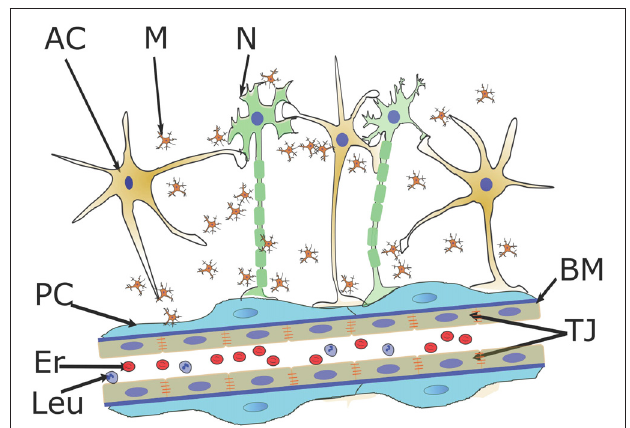
FIGURE 1 | Blood-brain barrier (BBB) structure and intercellular communications within the neurovascular unit (NVU). Brain microvessel endothelial cells (BMECs), pericytes (PC), basement membrane (BM), perivascular astroglial cells (ACs), microglia (M) and neurons (N) form the NVU where endothelial cell layer controls bidirectional transport of macromolecules and fluids, trafficking of immune and progenitor cells to the brain tissue. NVU serves as a platform for neuron-astroglia metabolic coupling, gliovascular control of microcirculation, glia- and pericyte-mediated control of BBB permeability and angiogenesis, vascular support of neurogenesis. Er, erythrocytes; Leu, leukocytes; TJ, tight